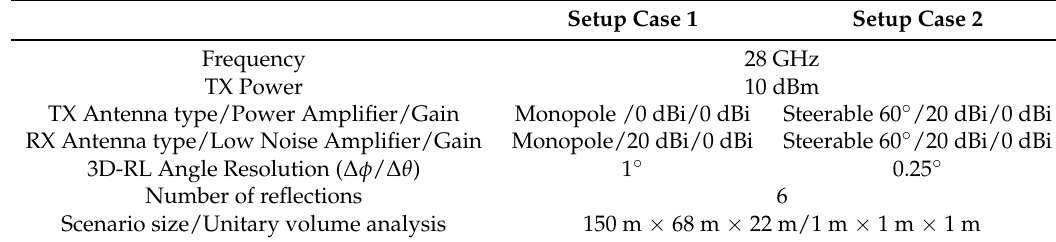
Table 2. RL algorithm simulation parameters.